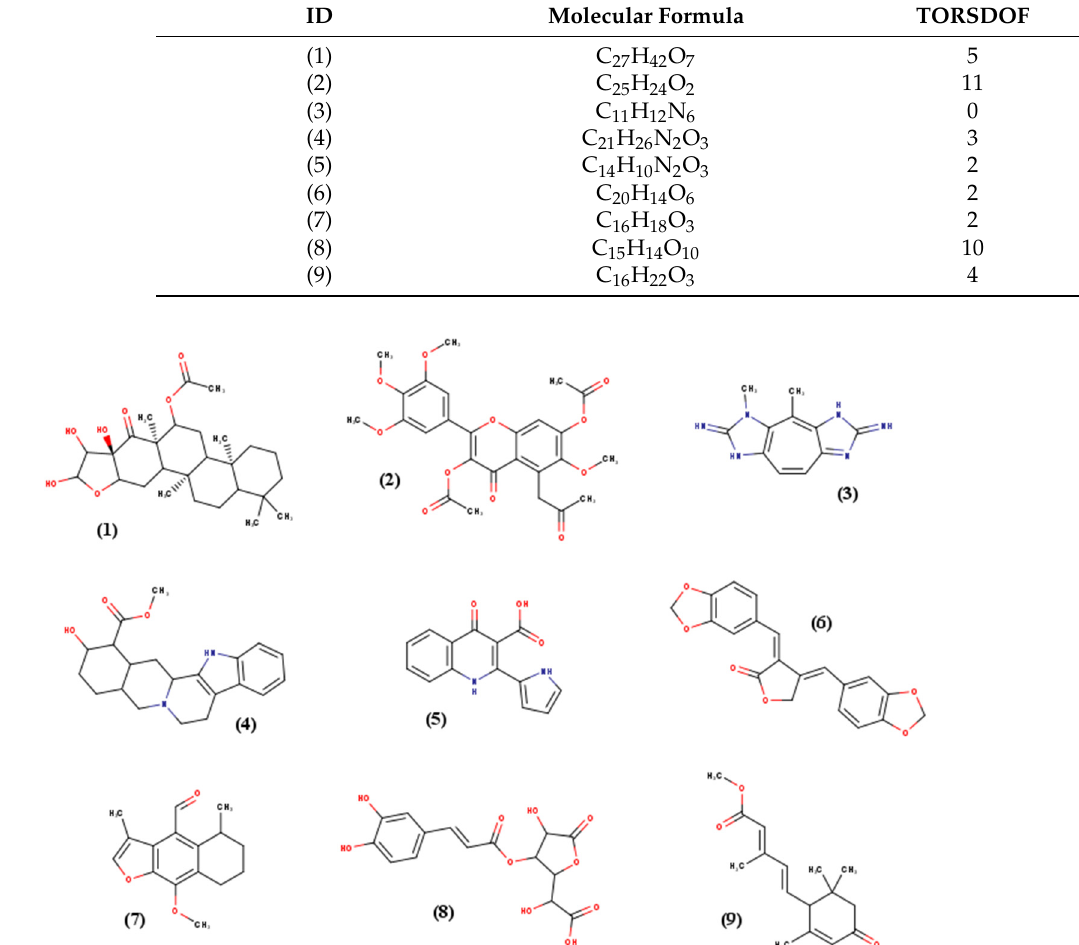
Figure 8. 2D representation of the nine ligands used in this study. These schemes illustrate the diversity in geometry as well as in the chemical functions.